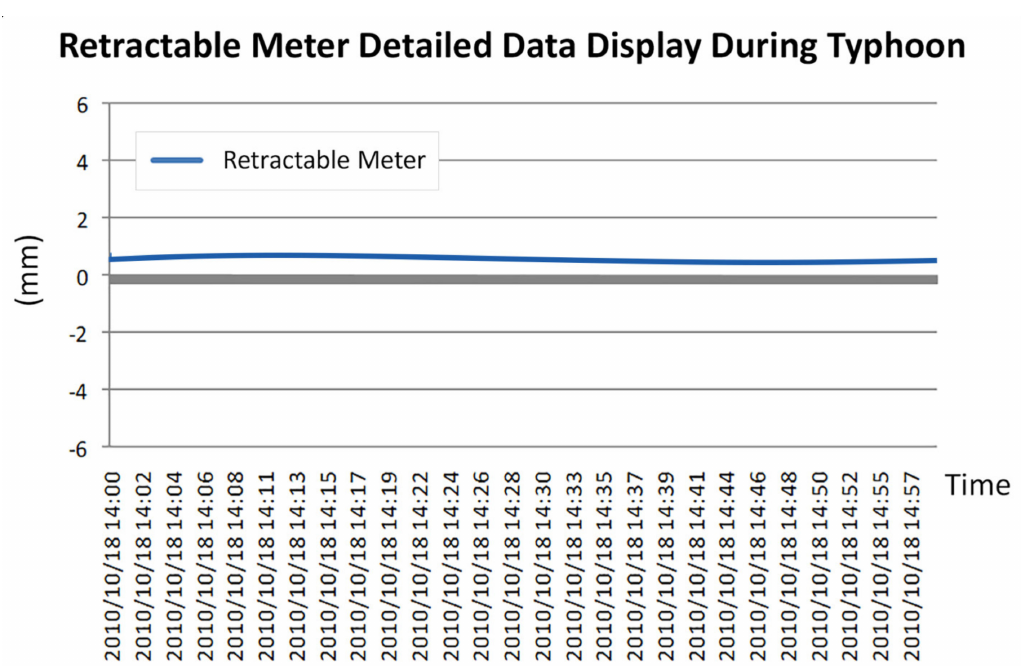
Figure 16. Detailed data display of the retractable meter during Typhoon Sinlaku (17–18 October